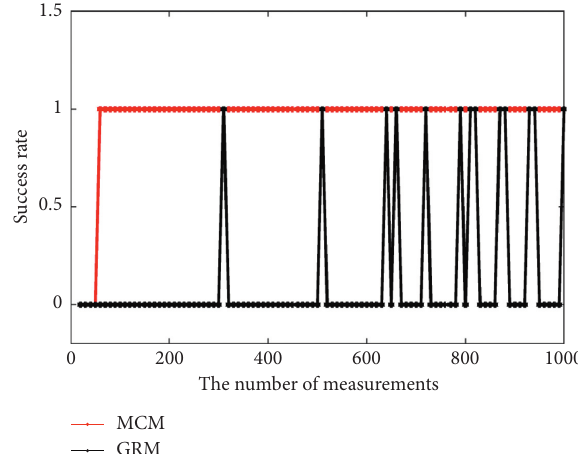
Figure 13: Comparison of detection effect of two measuring